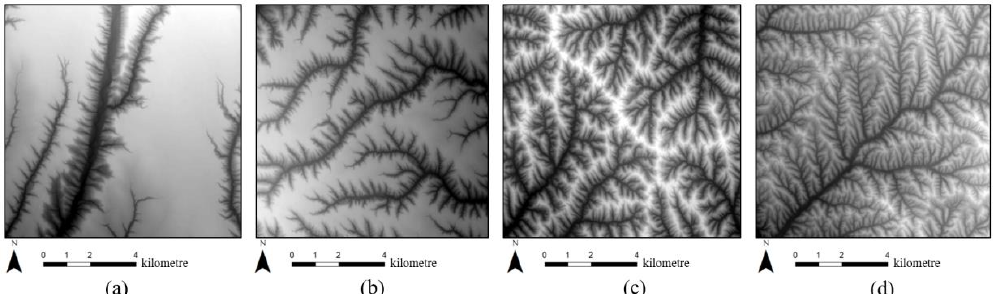
Figure 1. DEM visualisation of typical landform of Loess Plateau. ( a ) the early stage of loess tableland; ( b ) the late stage of loess tableland; ( c ) loess ridge area; ( d ) loess hill